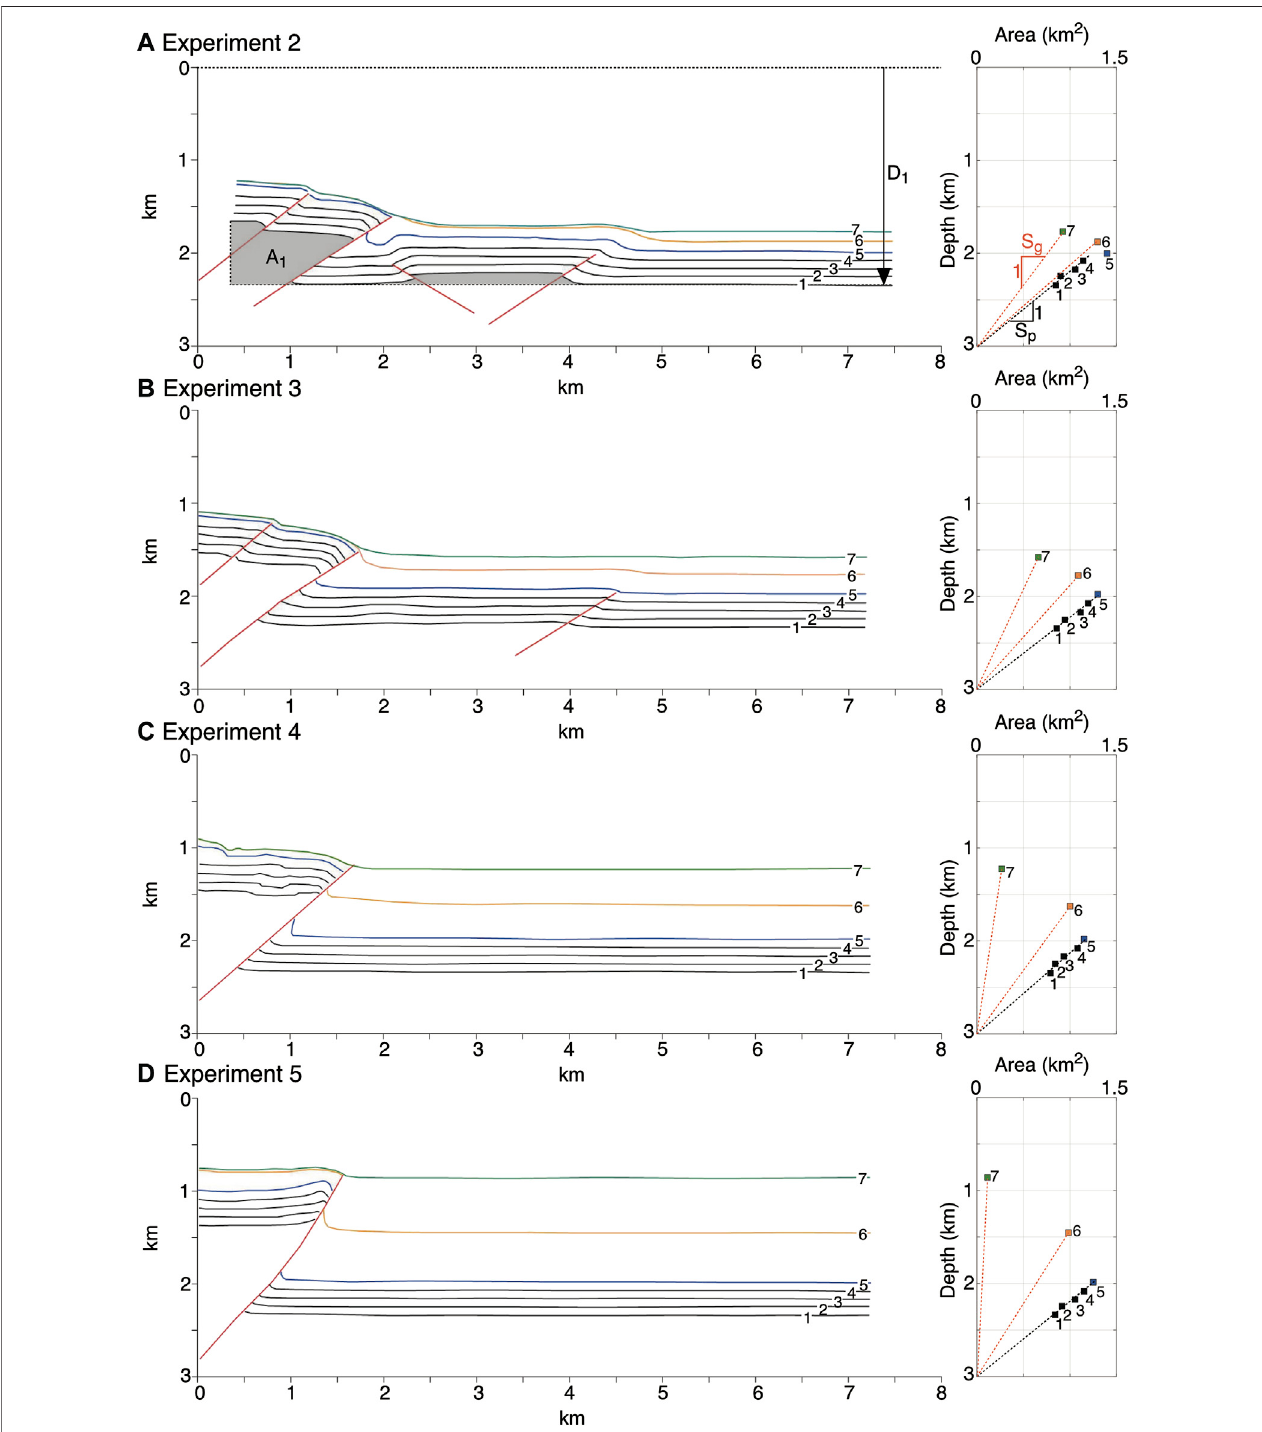
FIGURE9| Interpretations (left) andexcessareaversusdepthgraphs (right) ofexperiments (A) 2, (B) 3, (C) 4,and (D) 5.Theexperimentaldetachmentisat3 km in these graphs, 1.3 km in undeformed sections. Four pre-growth layer boundaries (layers 1 – 4), the top pre-growth (layer 5), and the tops of the early (layer 6) and mid/ late(layer7)growthsequencesareincluded. (A) showshowthedepth(D1)andexcessarea(A1,greypolygon)oflayeronearedetermined.Thislayerthenplotsaspoint 1in thearea-depth graph.Thesamemeasurements aretakenfortheotherlayers, which arethenplottedinthearea-depth graph(points2 – 7). (A) also showshow the pre-growth displacement Sp, and growth displacement Sg are estimated from the area-depth graph. Sp and Sg are the inverse of the slopes of the black and red dashed lines, respectively.